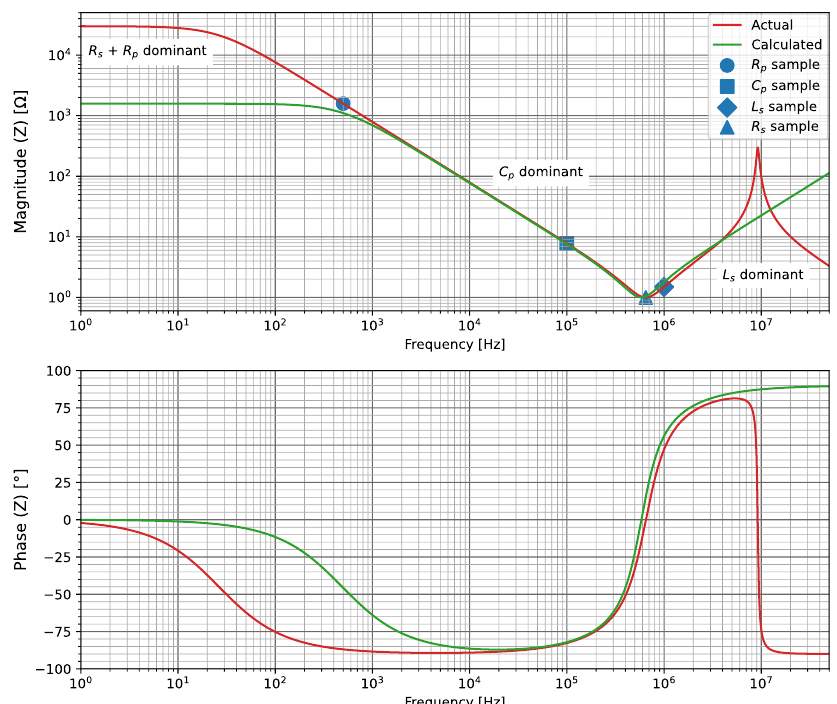
Figure 13. Impedance curves for the small-signal AC sub-model (SSACSM), where the “actual” trace represents the true impedance of the DUT, and the “calculated” trace represents the reconstructed impedance. Good agreement is not shown. This illustrates the importance of: (1) correct sampling and (2) avoiding